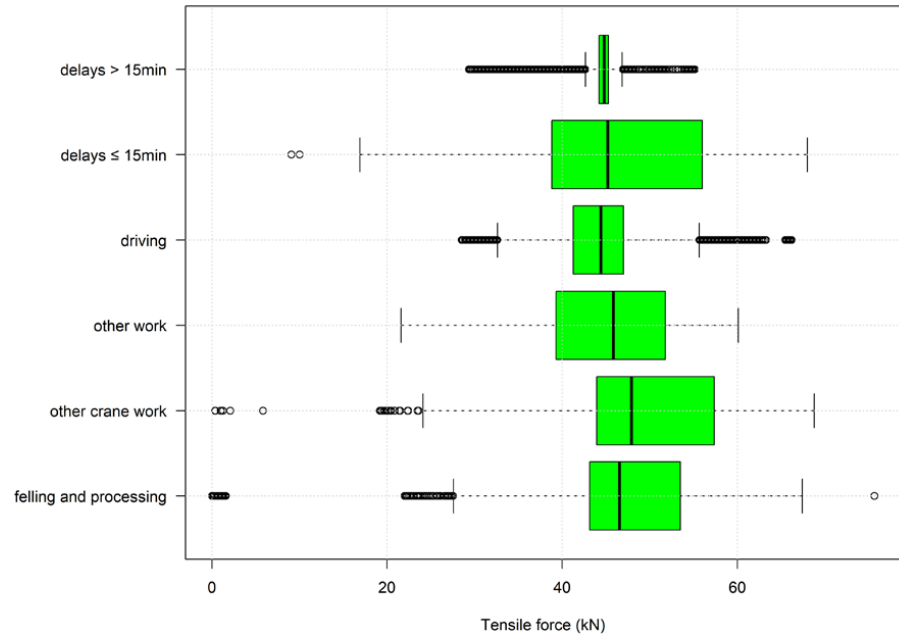
Figure 7. Tensile forces divided into defined work phases of the observed harvester for all captured data. Each box plot contains whiskers including data from 2.5% to 97.5%, boxes from 25% to 75%, and the black line denotes the median. Outliers are marked as